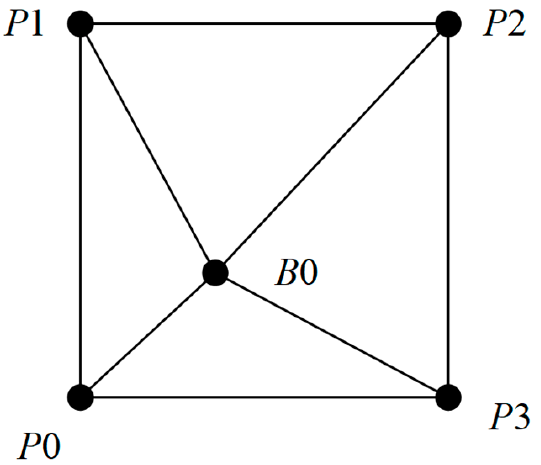
◦ pseudo pixel point in a Figure 4. Sketch map of 22.5° pseudo pixel point in a square. Figure 4. Sketch map of 22.5